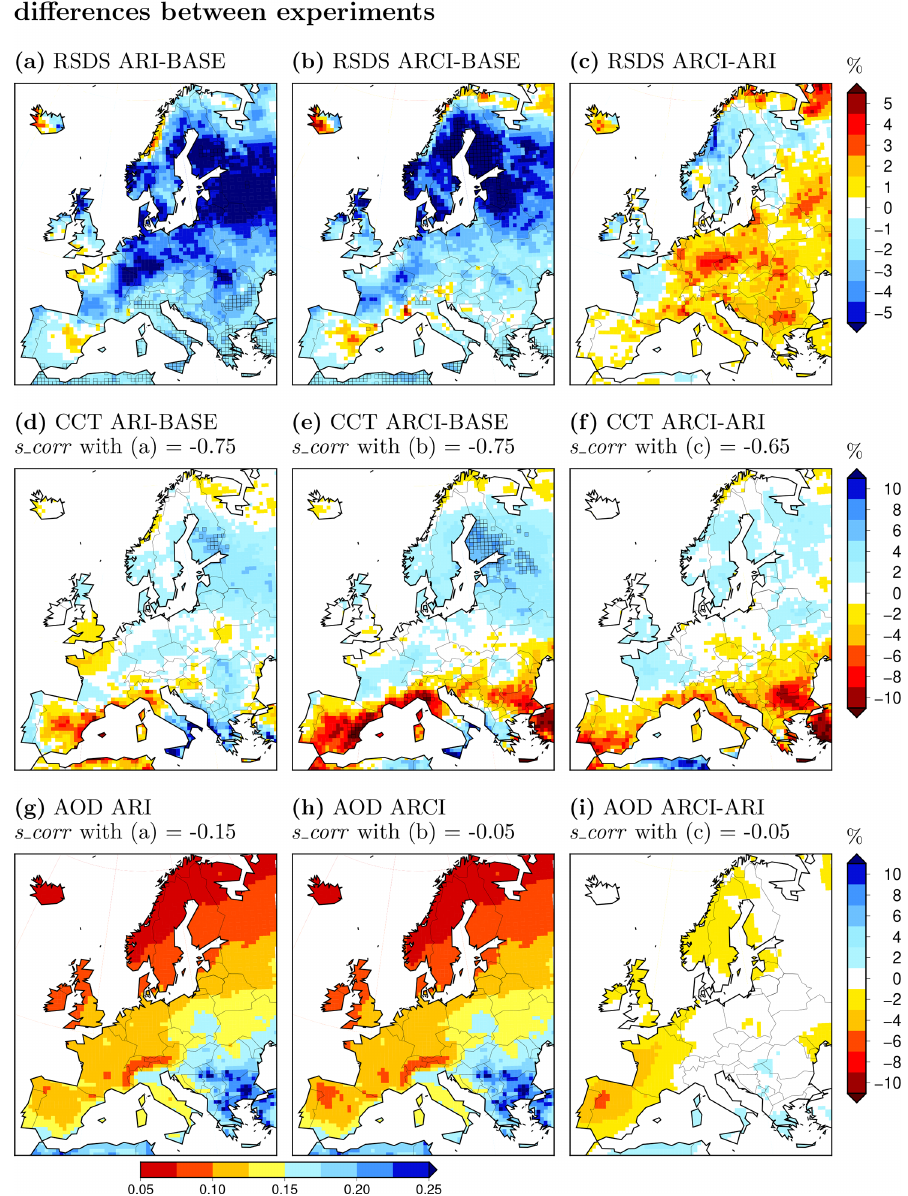
Figure 1. Relative differences between the WRF simulations in the RSDS (a–c) , CCT (d–f) and AOD (at 550nm) (g–i) summer (JJA) climatologies in the historical period (1991–2010); squared if statistically significant ( p < 0 . 05; units: percent). Note that panels (g) and (h) refer to the horizontal color bar just below them and simply represent the AOD summer climatologies in ARI and ARCI, respectively. Spatial correlations ( s_corr ) between the patterns in the second and third rows and the respective patterns in the first row are indicated in the headers.